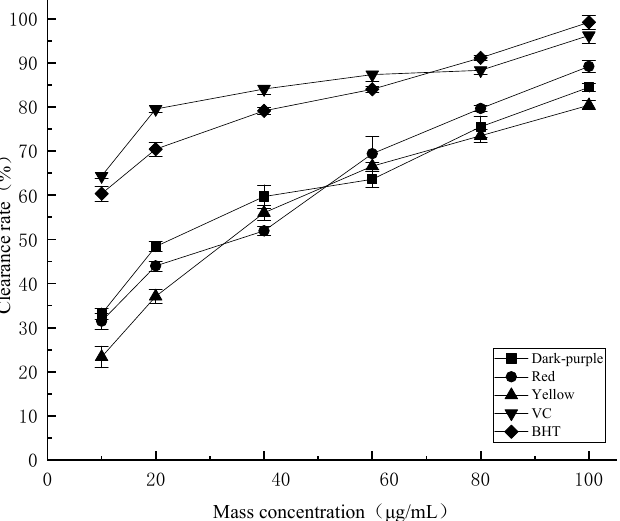
Figure 4. Comparison of the DPPH radical scavenging activities of the essential oil for different colors of P. delavayi flowers.